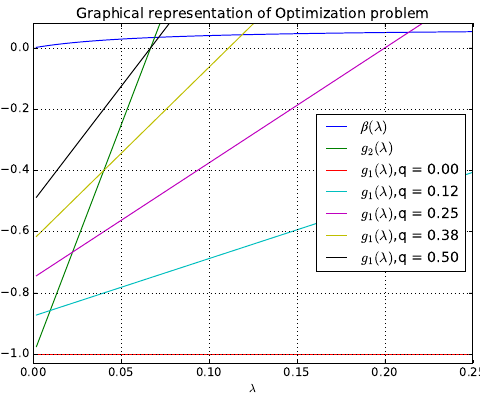
Figure A2. Graphical representation of Optimization